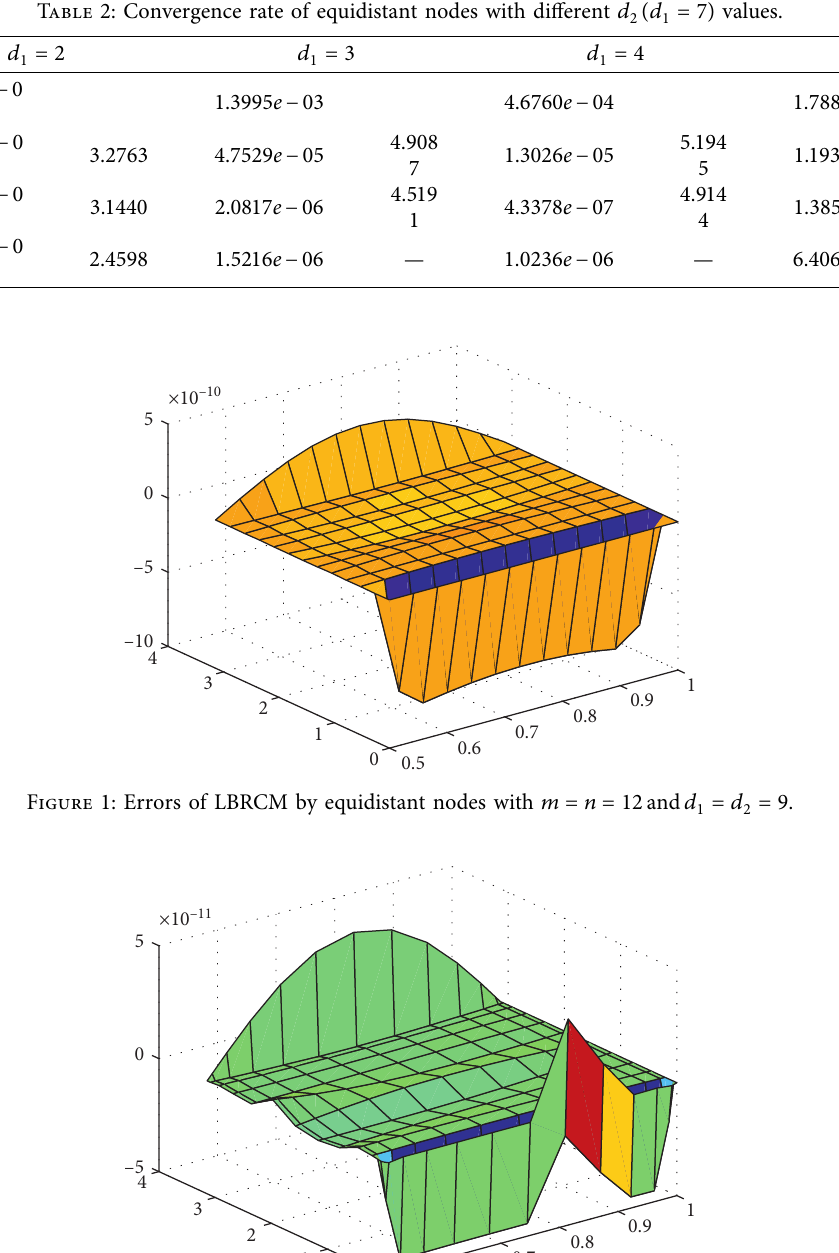
Table 1: Convergence rate of equidistant nodes with different d